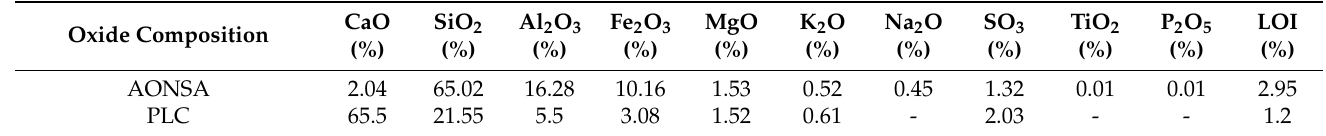
Table 1. Oxide compositions of the binding materials used.